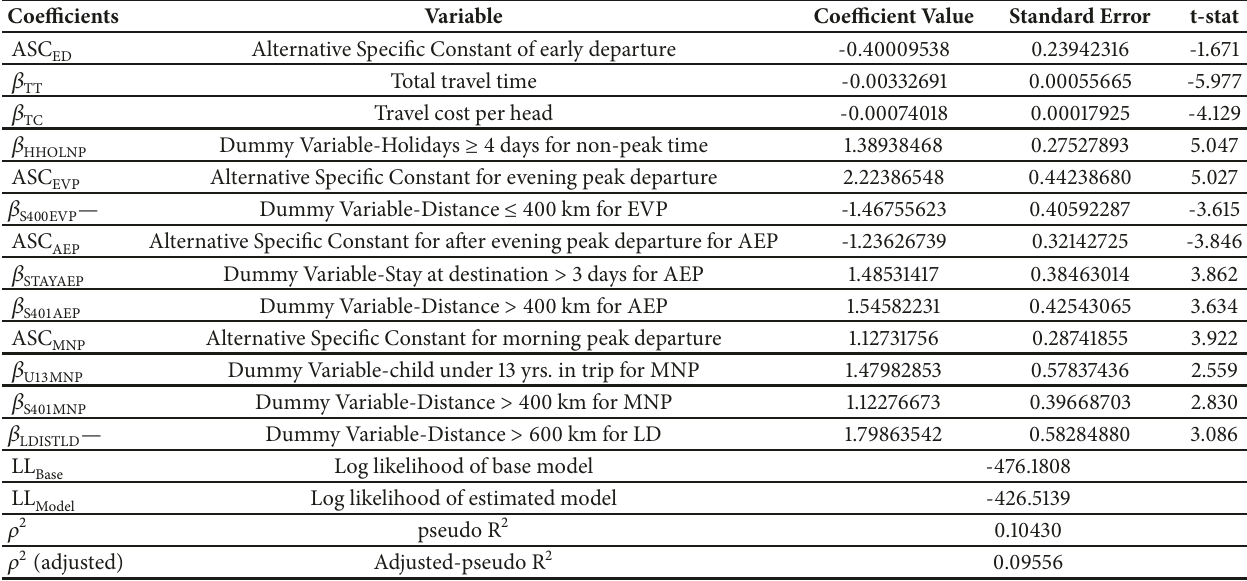
Table 3: Estimation results of the MNL-DTC model.